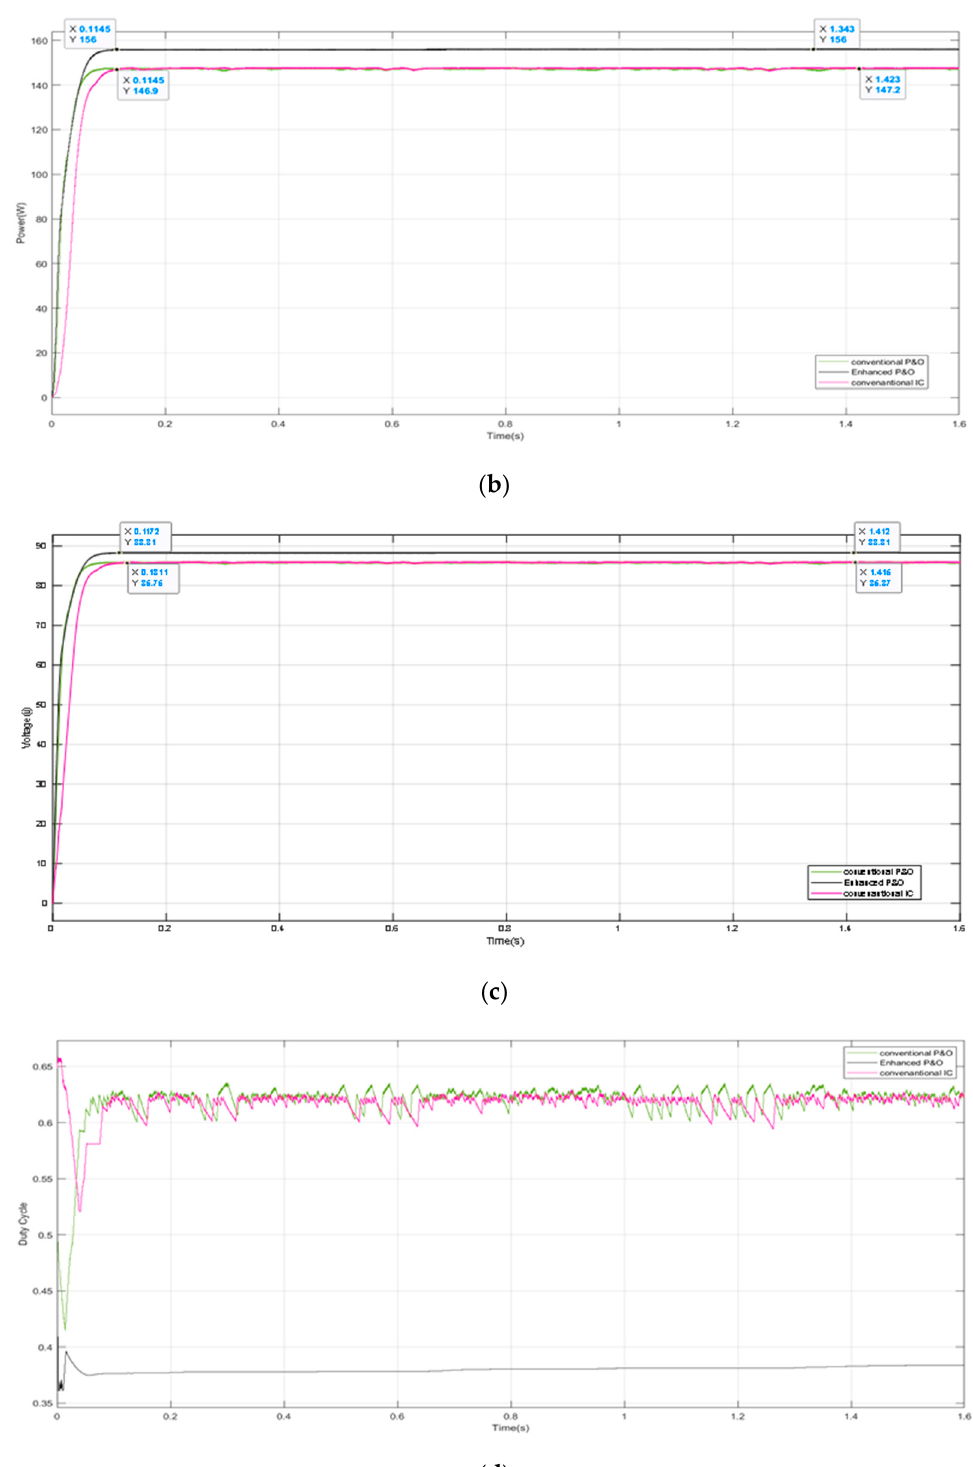
Figure 19. ( a ) Scenario of case “c” of the (4S) PV array; ( b ) The extracted power by the proposed technique and the conventional P&O and IC techniques; ( c ) The voltage at the boost converter output; ( d ) The duty cycle behaviors.